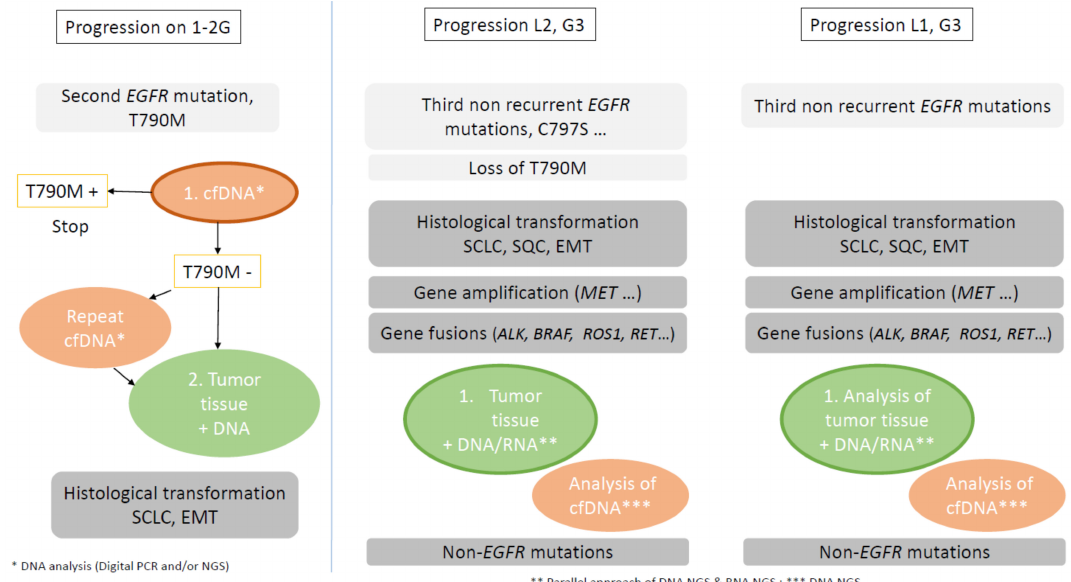
Figure 4. Strategy for molecular analysis at progression under EGFR-TKIs.